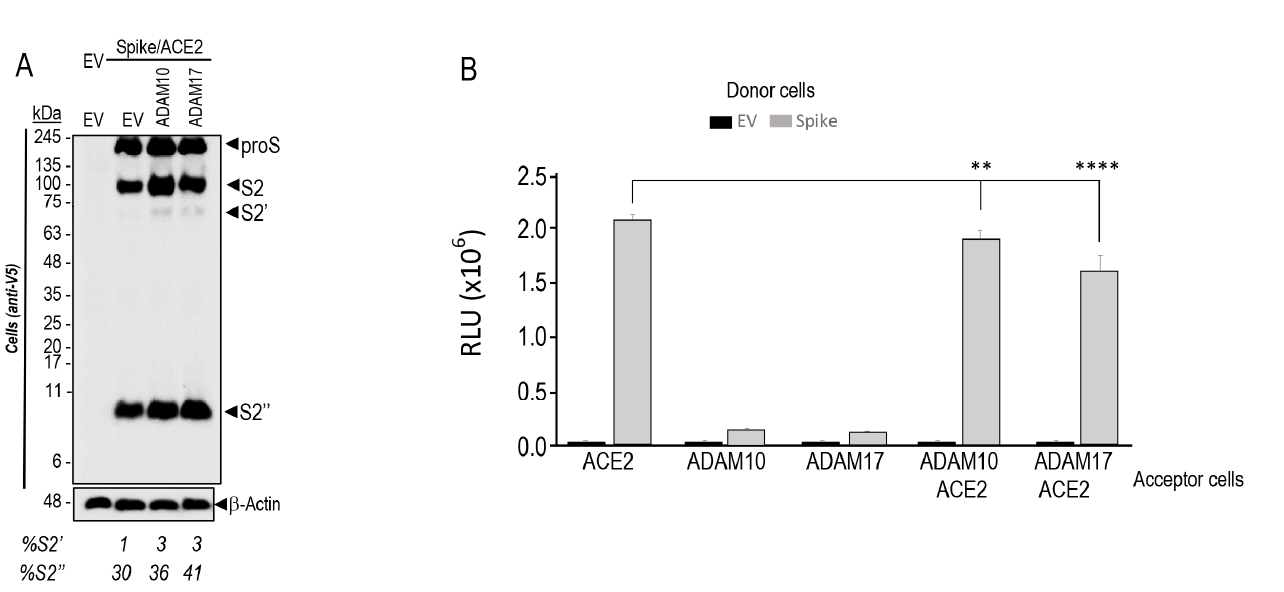
Figure 6. Overexpression of ADAM10 and ADAM17 increases the generation of S2 (cid:48) and S2 (cid:48)(cid:48) products but decreases cell-to-cell fusion. ( A ) HeLa cells were transiently co-expressed with double-tagged spike protein (N-terminal HA-tag; C-terminal V5-tag), WT (S), and ACE2 alone or in combination with empty vector (EV), ADAM10 or ADAM17. The V5 immunoblot shows the analysis of cell extracts 28 h post transfection. Note that we had to overexpose the gel to better see S2 (cid:48) . ( B ) Donor HeLa cells expressing empty vector (EV) or spike-glycoprotein WT (S) were co-cultured with acceptor TZM-bl cells expressing ACE2 and/or ADAM10 and ADAM17. The extent of fusion is represented as relative luminescence units (RLU). Representative blots of at least three independent experiments are shown. p values (**, p < 0.01; ****, p < 0.0001) were evaluated by a Student’s t -test.